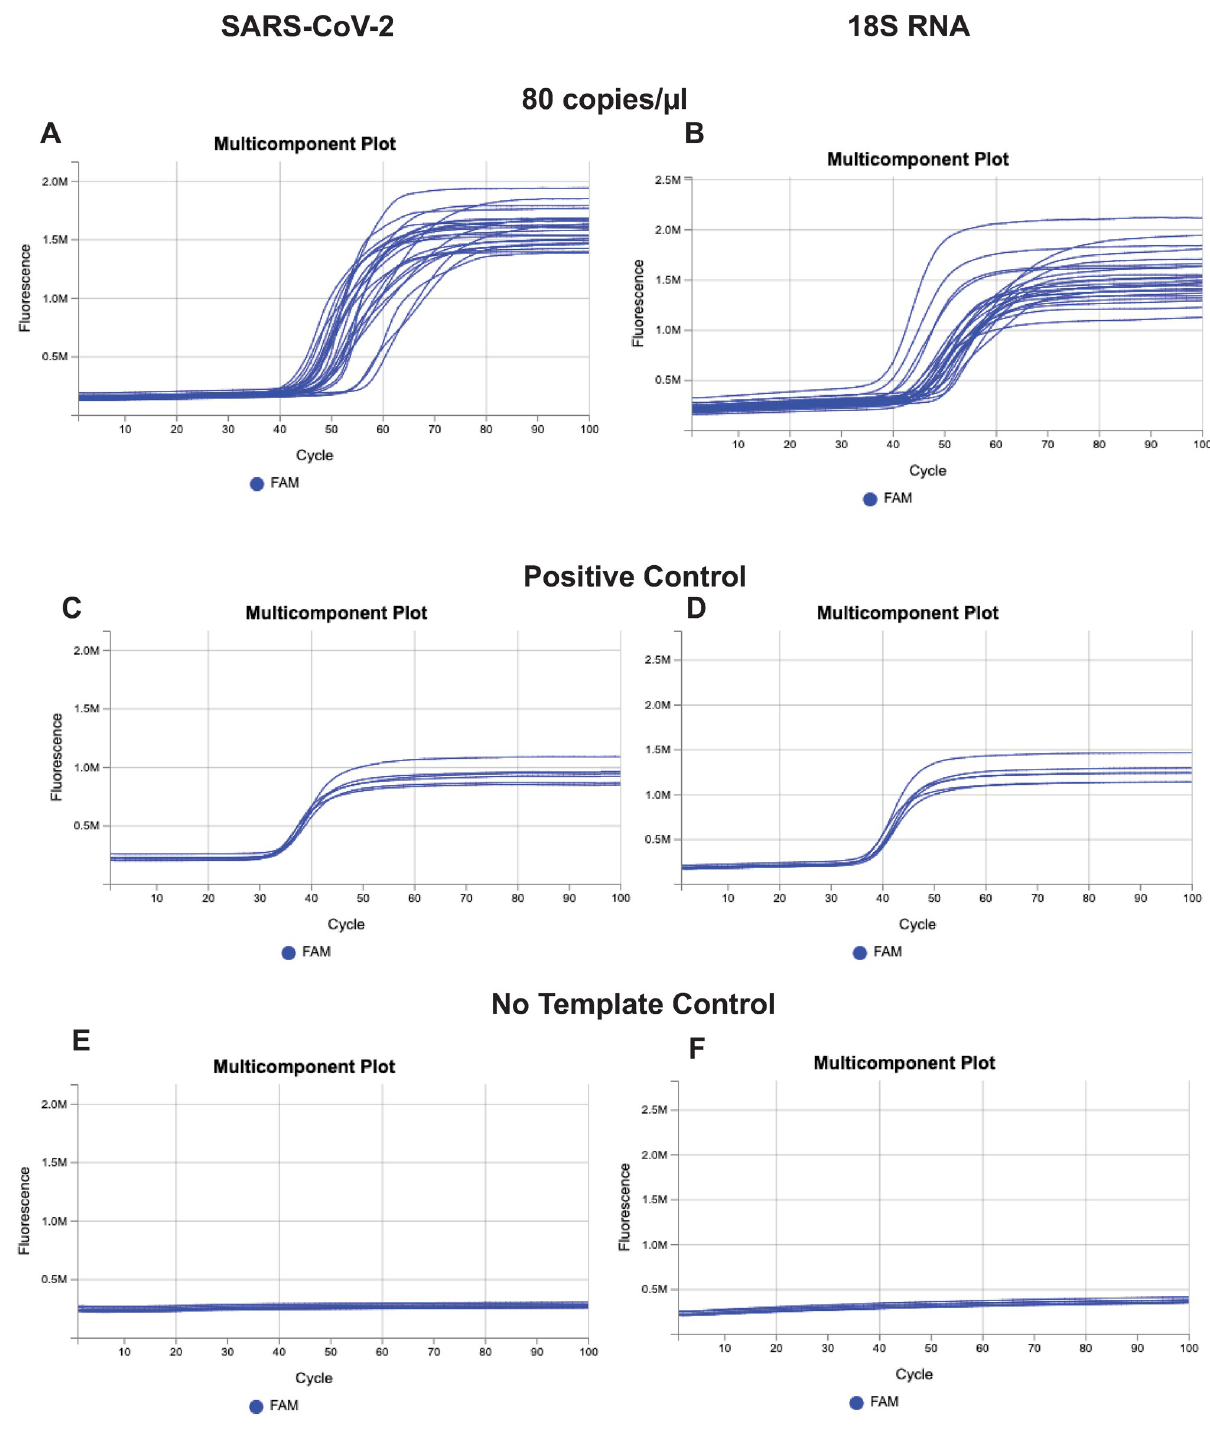
Fig 1. Amplification plots for SARS-CoV-2 and 18S RNA.